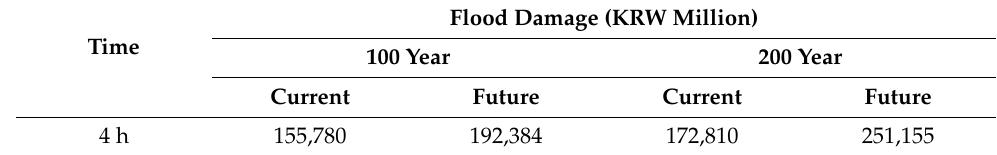
Table 4. Result of Flood Damage.